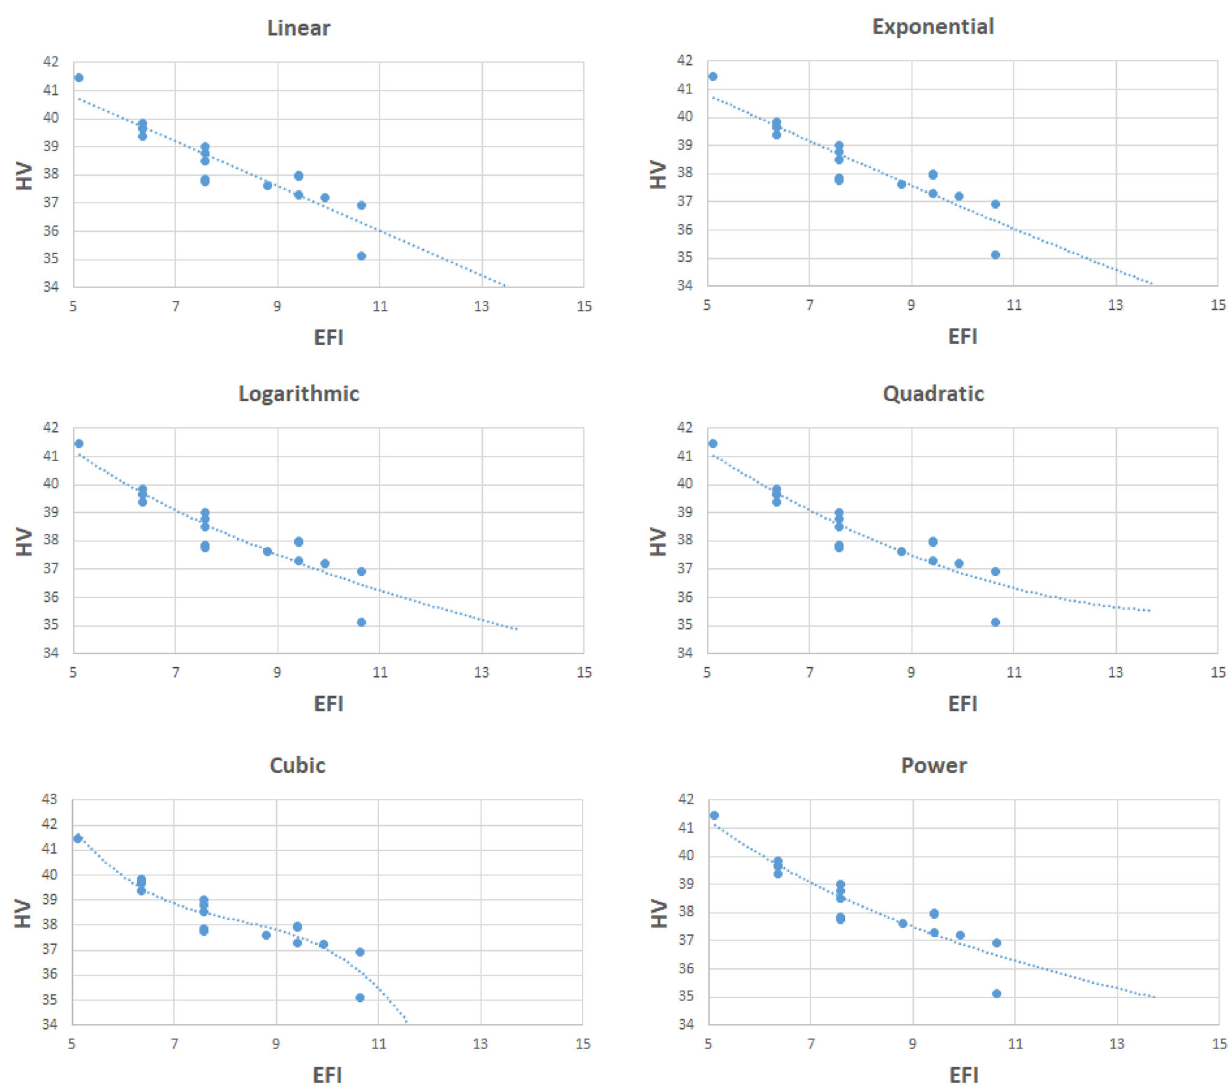
Fig. 7 The correlation of edge F-index with heat of vaporization for octane